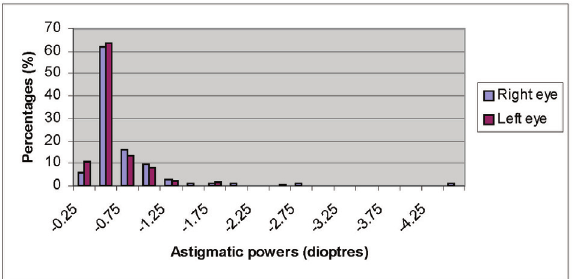
Figure 4 Graphical representation of the distribution of the cylindrical powers in the right and left eyes of the subjects. The graph peaks at 60% and most powers were ≤1.25